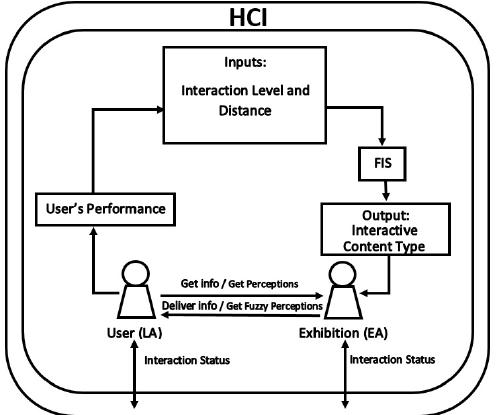
Figure 4. Agents involved in human–computer interaction (HCI). The figure shows the principal agents’ interactions among each other and their context. LA, learner agent; EA, education